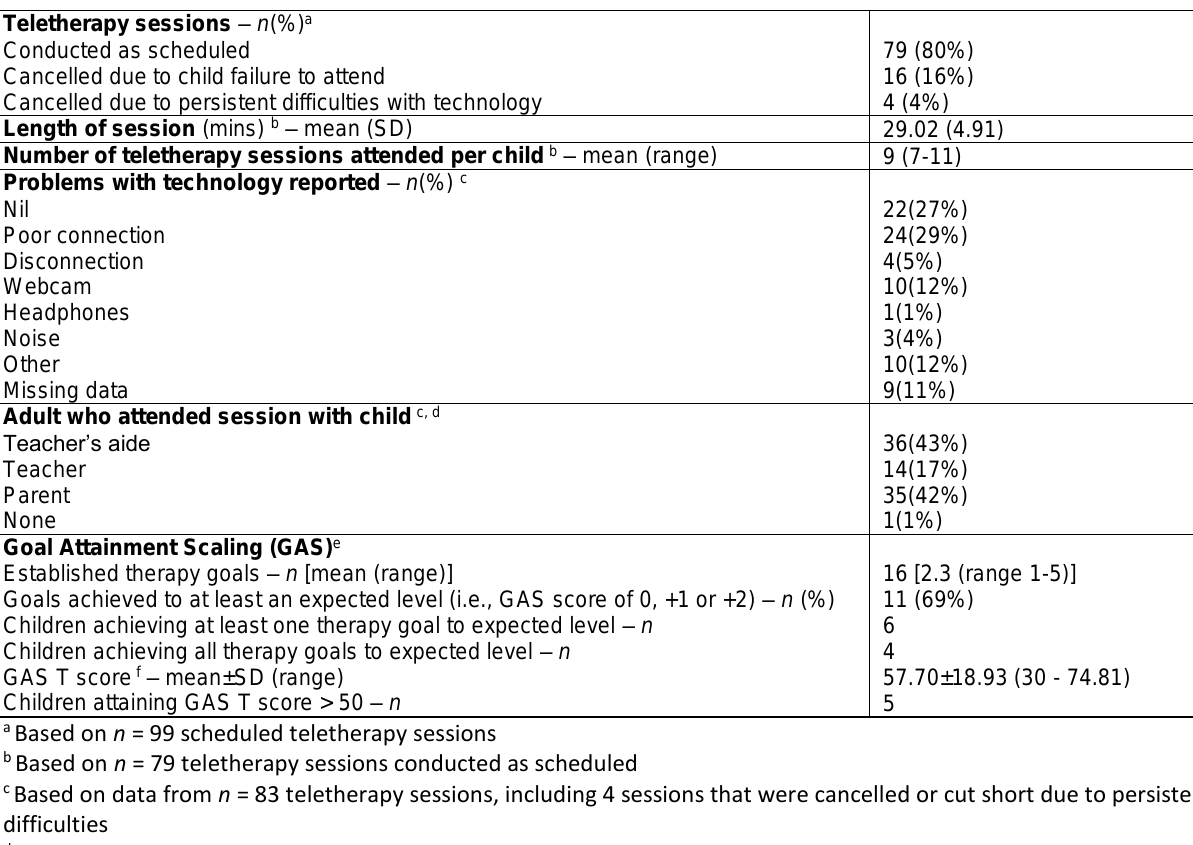
Table 2. Come N See Teletherapy Sessions and Therapy Outcomes